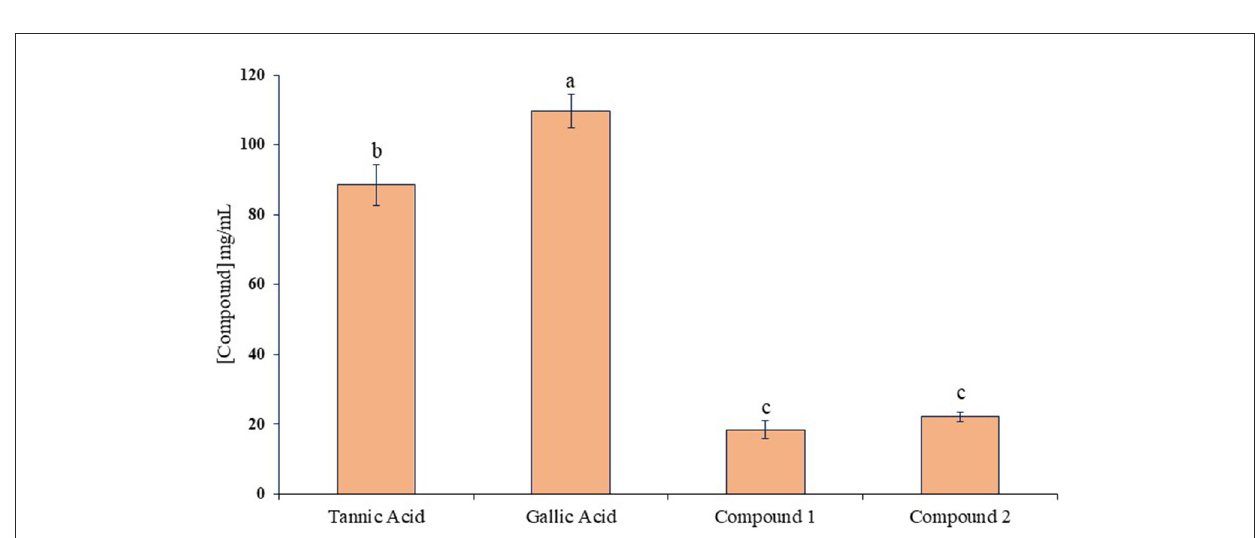
affinity of compound 1 to bind cellulase enzyme in less quantity, and consequently, this might have effects on fiber digestibility. Tannic acid and gallic acid exhibited significantly ( p < 0.01) higher reduction in both GPT and GOT than did compounds 1 and 2. In the case of cellulase enzyme activity, tannic acid was more effective than gallic acid as the effective concentration to inhibit 50% activity (EC 50 ) was 89.13 and 109.65 mg/mL for gallic acid and tannic acid, respectively. Both compounds 1 and 2 significantly ( p < 0.01) inhibited cellulase activity compared to both